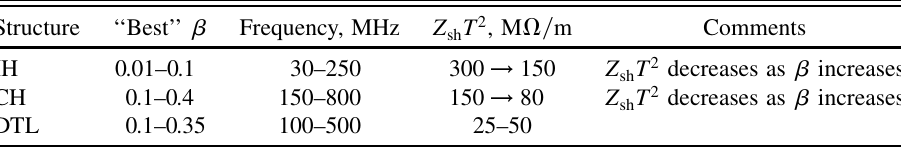
TABLE I. Parameters of low-energy room-temperature accelerating structures.